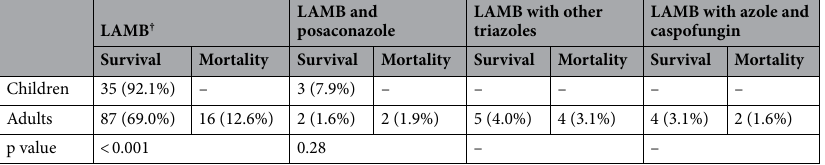
Table 2. Outcomes according to antifungal regimen in adults and children with confirmed mucormycosis (n = 164). † LAMB Liposomal amphotericin